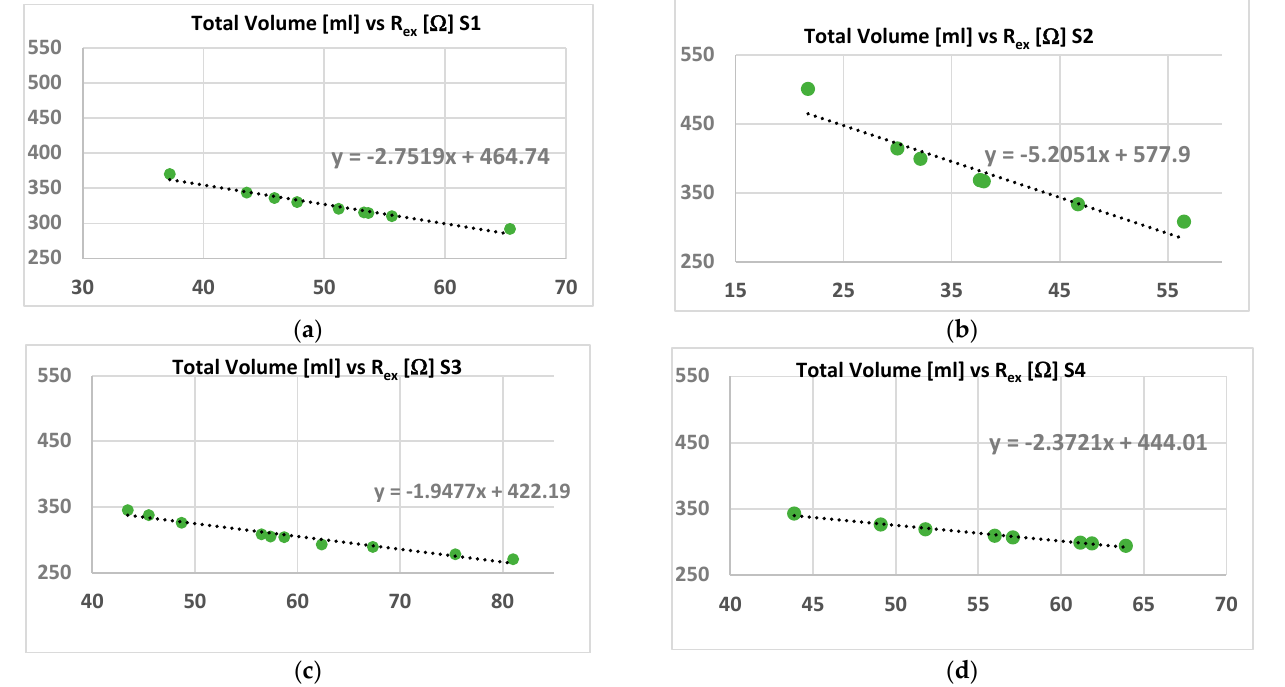
Figure 9. Volume estimation versus extracellular resistance R ex ( R_0 ) for healthy persons.